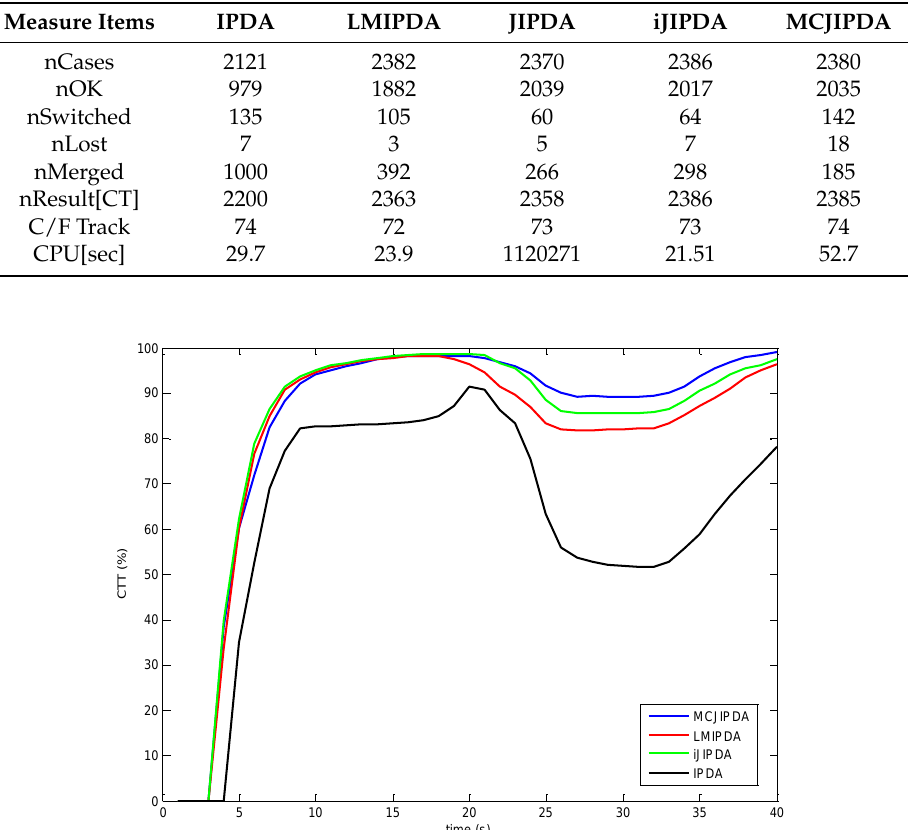
Table 4. Track retention statistics for Case #1.